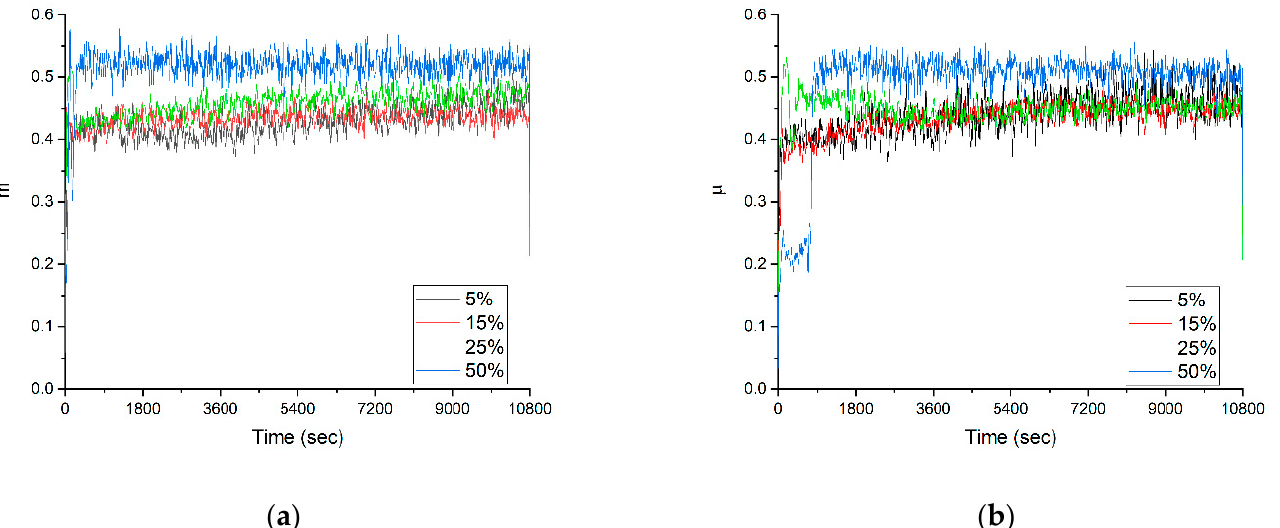
Figure 7. Friction coefficient ( µ ) of multimaterial samples during dry sliding friction tests using specimens cut out in the layer deposition direction ( a ) and wall growth direction ( b